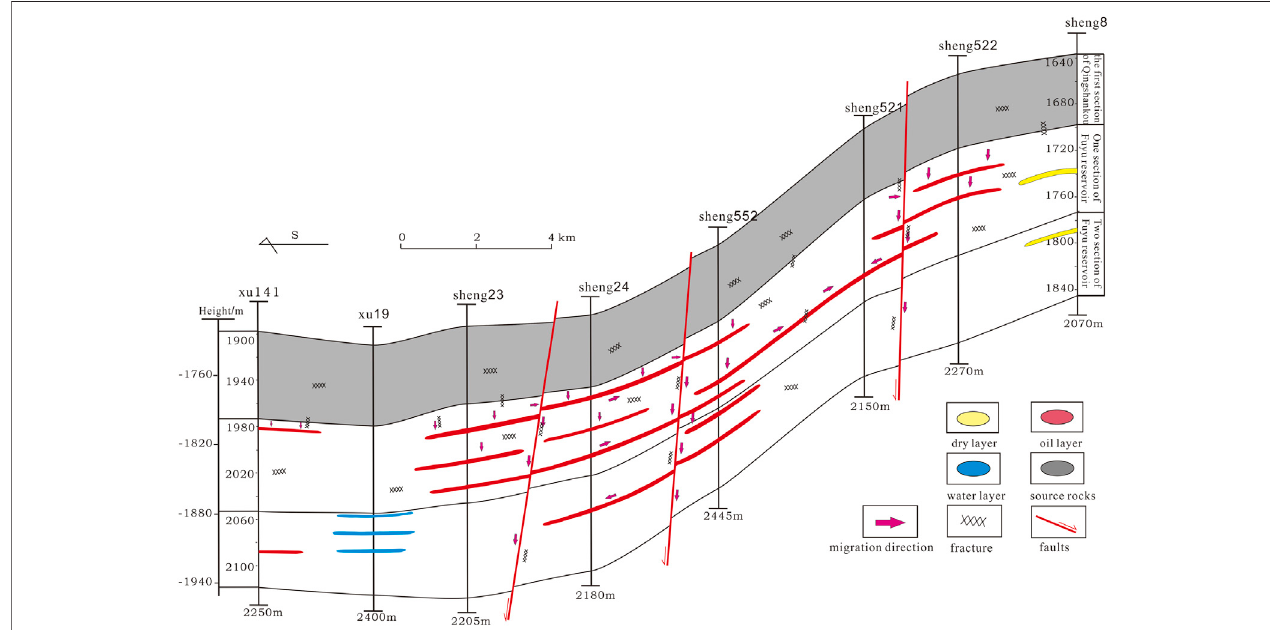
FIGURE 8 | Hydrocarbon charging and accumulation model in the Fang141-Sheng8 well in the Fuyu oil reservoir of the Sanzhao area.